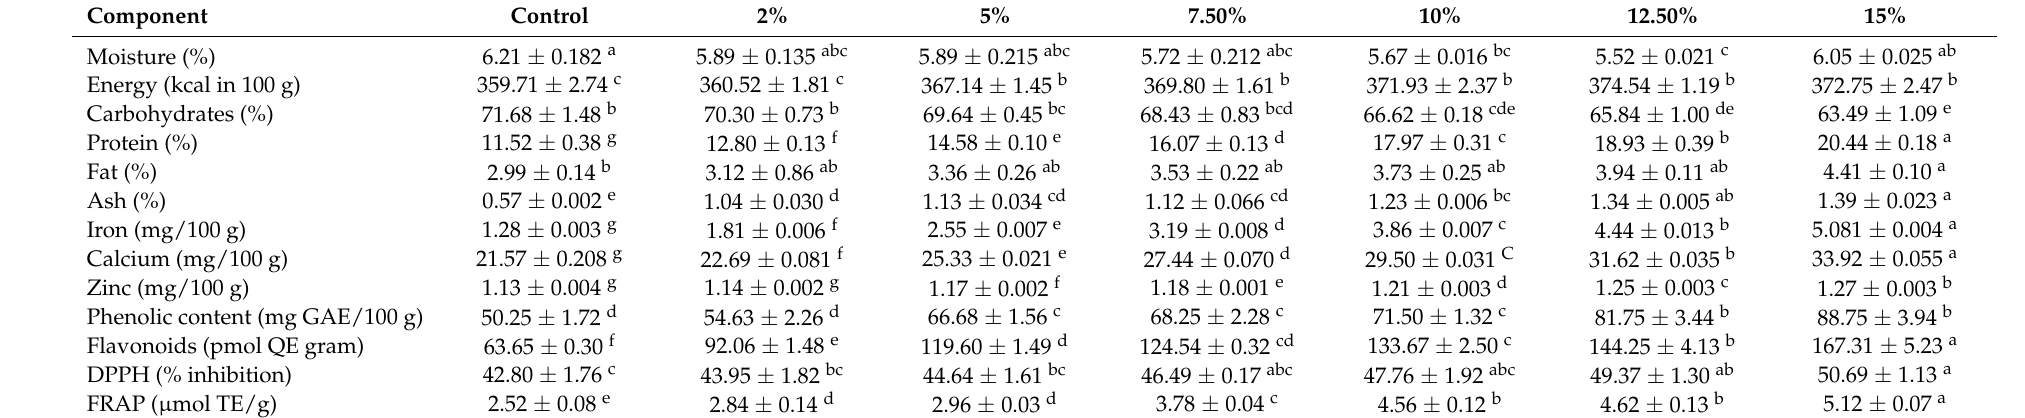
Table 2. Nutritional, phenolic, flavonoids and antioxidant content of different formulations of Spirulina biomass enriched